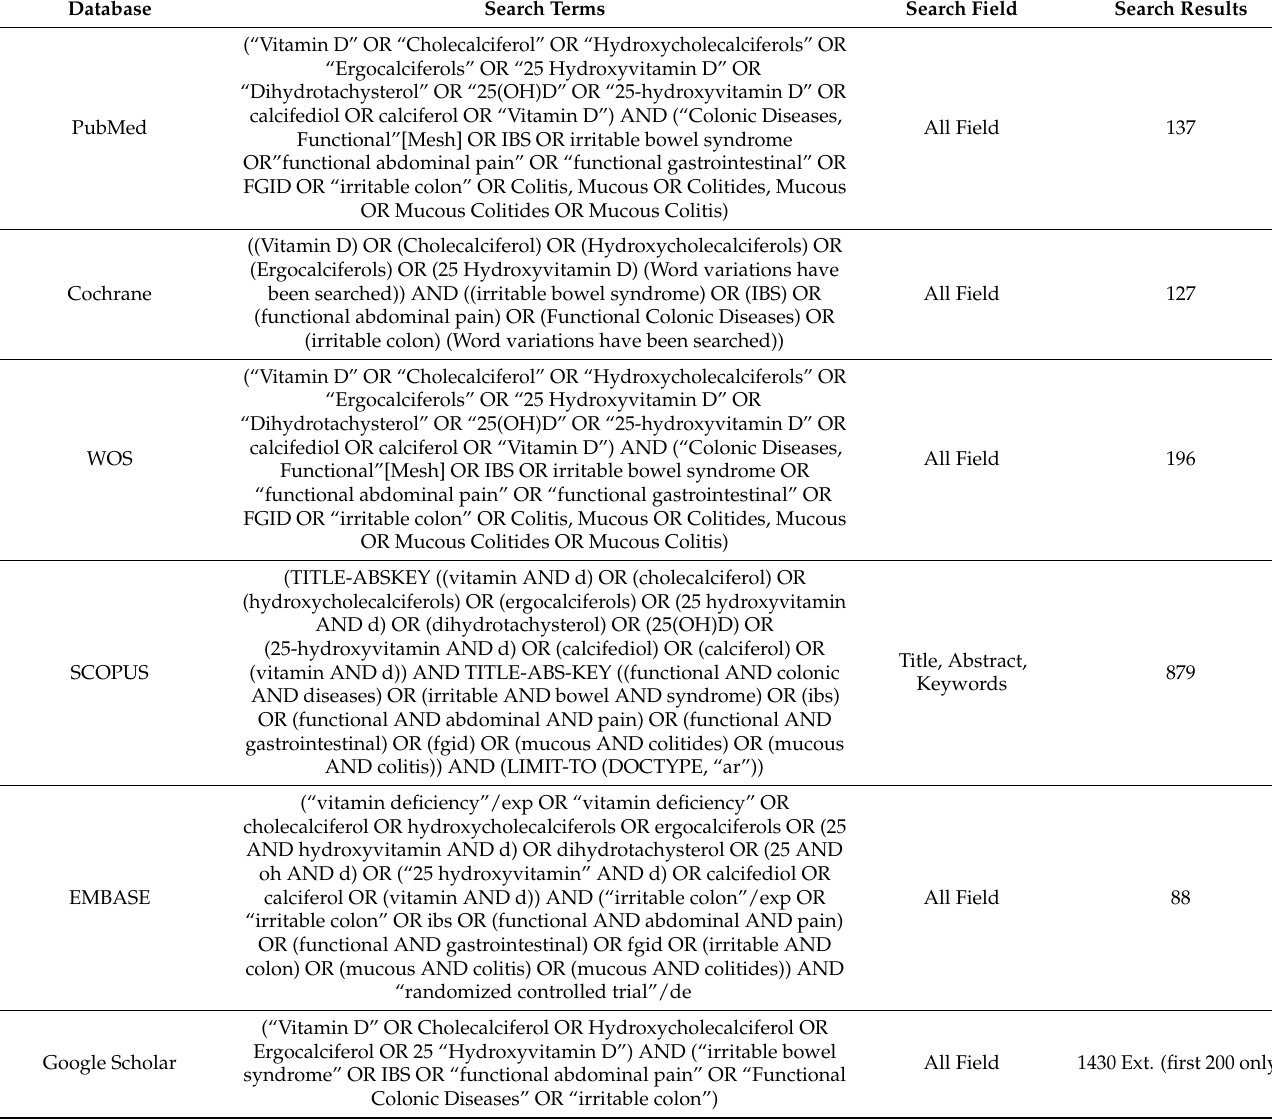
Table 1. Search terms and results in different